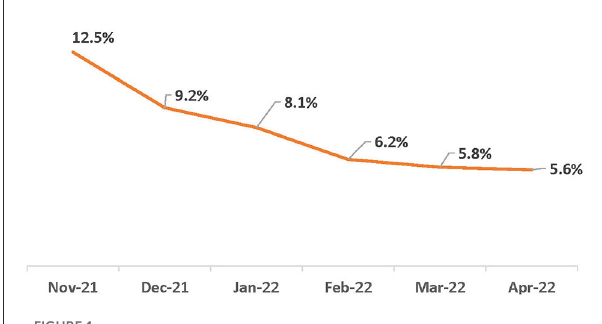
FIGURE1 Trend in both-tests (home-test and laboratory confirmed test) as % of any with home tests (home-tests-only and